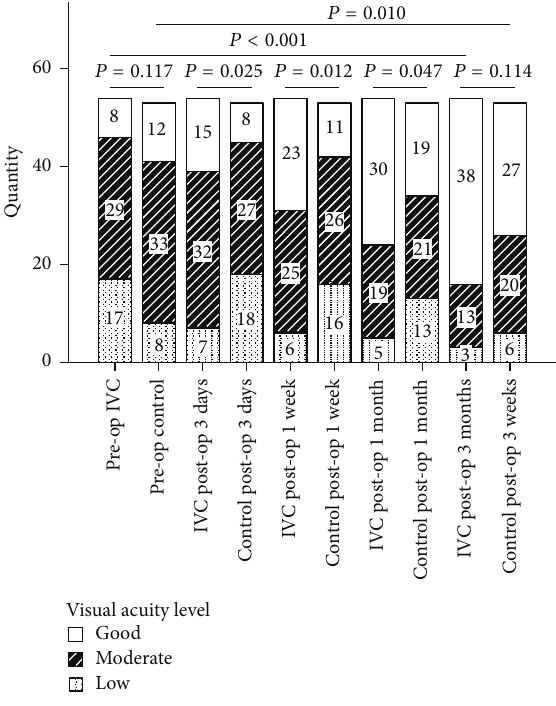
Figure 4: Bar graph showing best-corrected visual acuity levels in participantswithorwithoutconberceptpretreatmentpreoperatively and at 3 days, 1 week, 1 month, and 3 months after surgery. Subgroup pairwise analysis showed significant differences of visual acuity levels at 3 days ( 𝑃 = 0.025 ), 1 week ( 𝑃 = 0.012 ), and 1 month ( 𝑃 = 0.047 ) after surgery between preoperative IVC group and control group. However, there was no statistically significant difference at 3 months ( 𝑃 = 0.114 ) after surgery between the two groups. Compared with the preoperative period, visual acuity levels had a significant increase at 3 months after surgery in both groups ( 𝑃 < 0.001 , 𝑃 = 0.010 , resp.). IVC: intravitreal conbercept; pre-op: preoperative; post-op: